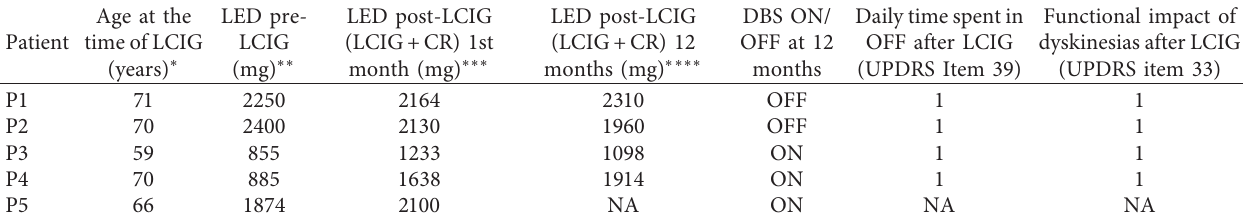
Table 2: Characteristic of the treatment with LCIG and levodopa-equivalent doses in the five